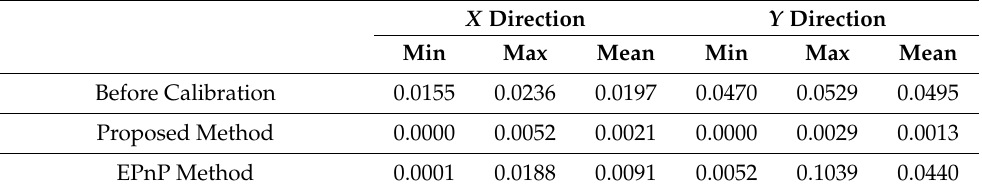
Table 5. Horizontal positioning error before and after